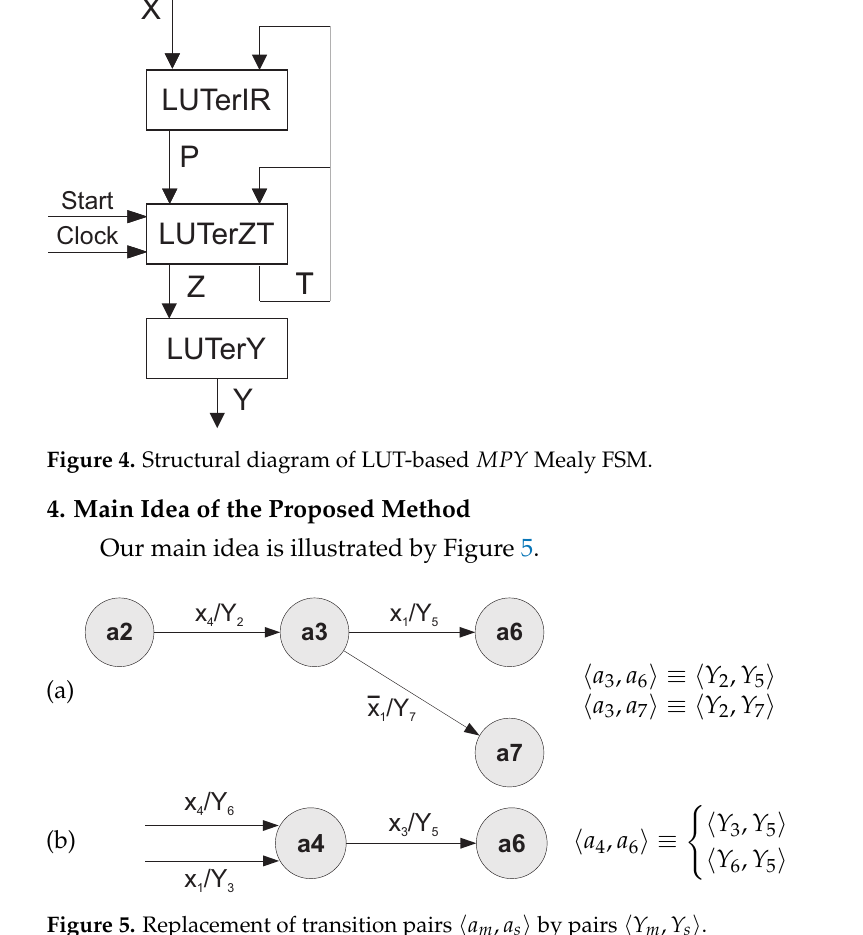
Y m , Y s (cid:104) (cid:105)